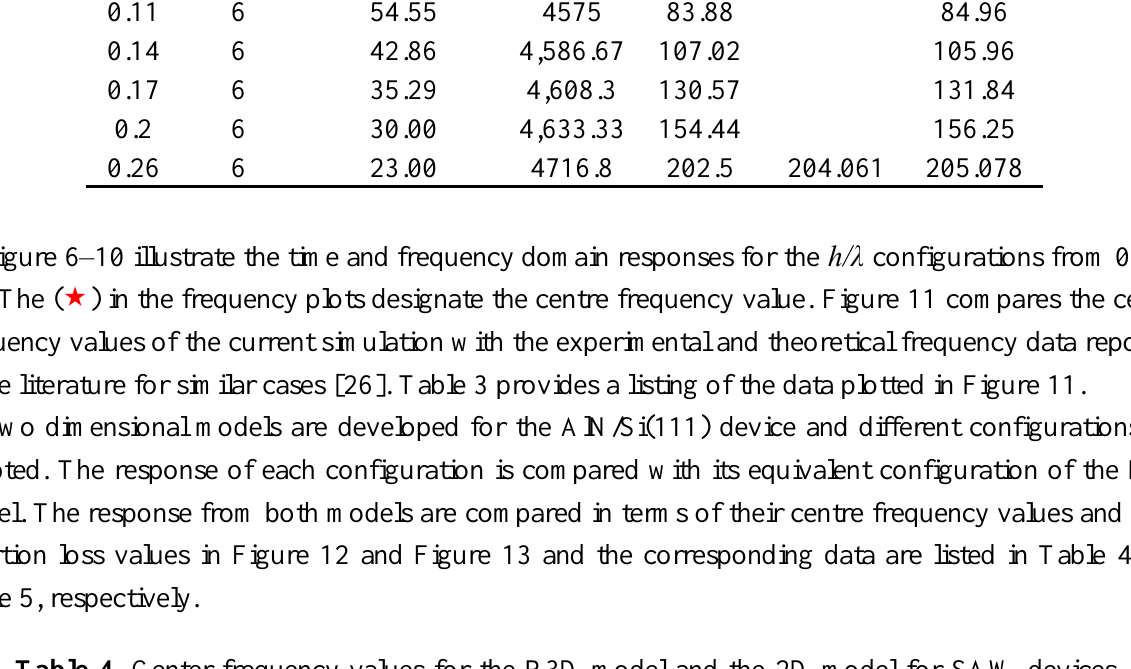
Table 4. Center frequency values for the R3D model and the 2D model for SAW devices with different h /λ values.